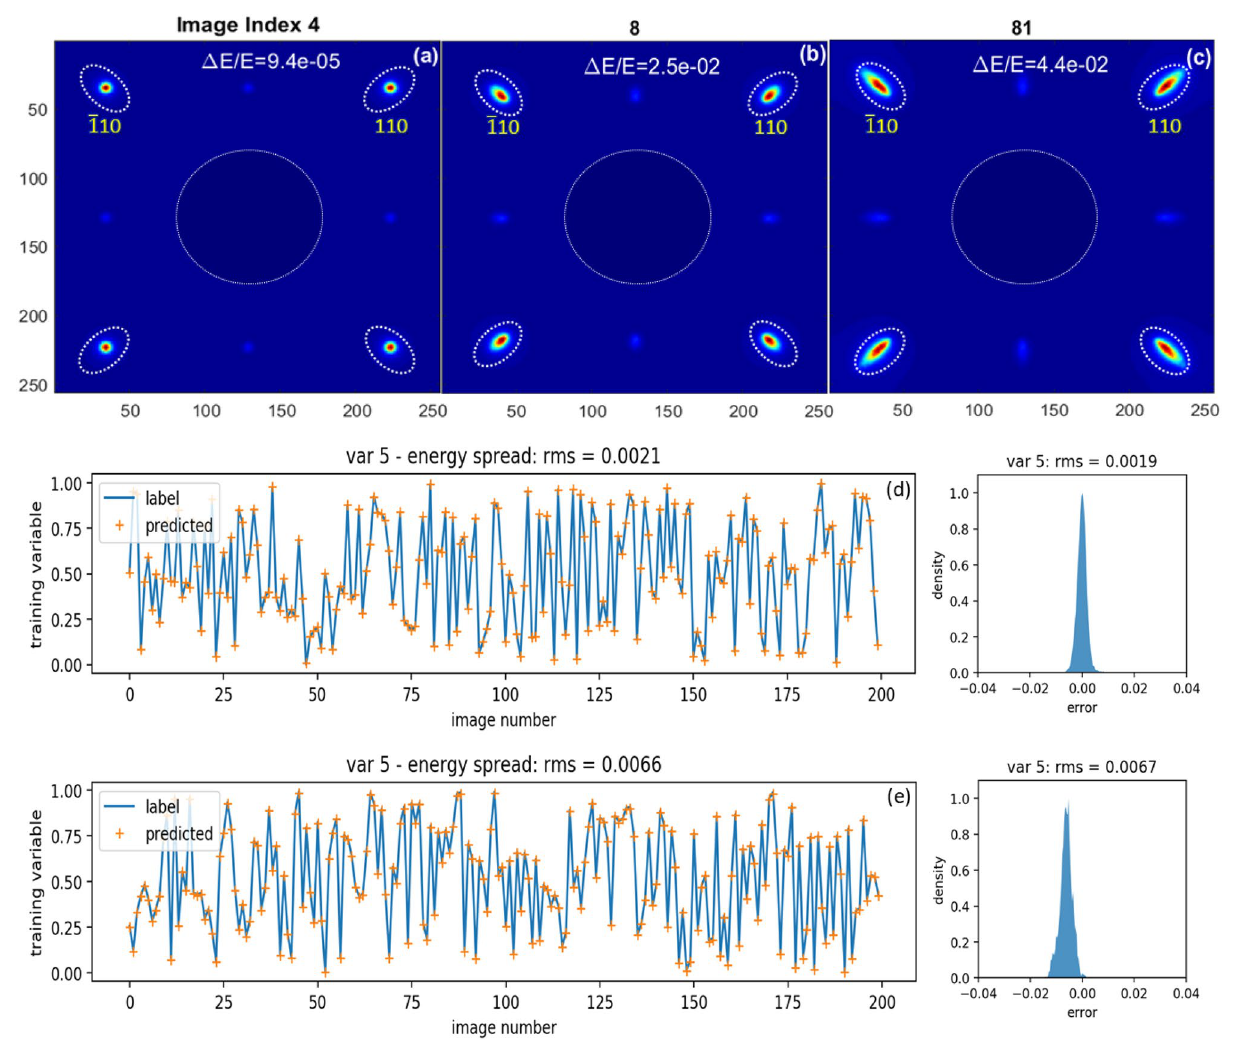
Figure 4. Simulated BD patterns of SrTiO 3 single crystal along [001] direction of the dataset #2 with the RMS energy spread of 2 × 10 –2 have the index 4 ( a ), 8 ( b ) and 81 ( c ) from left-to-right. Their corresponding training variables are 0.00204, 0.55412 and 0.95690, respectively. With the unit conversion of 0.04584, the energy spread is labeled in each image. Here, variable 5 multiplied by the unit conversion equals to the energy spread. The image has a size of 256 × 256 pixels, with an angular resolution of 100 pix/mrad in the EDP simulation. For each image, the view angles are the same in x and y directions: ± 1.28 mrad. Miller indexes of selected Bragg peaks, ¯ 110 ( ) and (110), are labeled (yellow). The dashed circle represents the hole of the mirror in the detector system. ( d ) The input data label is plotted as the blue curve while the corresponding prediction is plotted as the orange cross. The corresponding error distribution for the entire dataset of ten thousand images is plotted on the right side. ( e ) For the simulated dataset #3, with the RMS energy spread of 5 × 10 –3 , the input data label is plotted as the blue curve while the corresponding prediction is plotted as the orange cross. Similarly, the corresponding error distribution for the entire dataset of ten thousand images is plotted on the right side. The RMS errors for the untrained images and the entire dataset agree extremely well. The neural network architecture used for these trainings is almost identical to the one shown in Fig. 2, with the only difference as the number of variables in the output (green triangle) jitters, only 3000 to 4000 images are needed for a predictable ML model with an accuracy better than 99%. It takes only about 20 min on a NVIDIA GeForce RTX 2080 GPU card in the experiment at the BNL